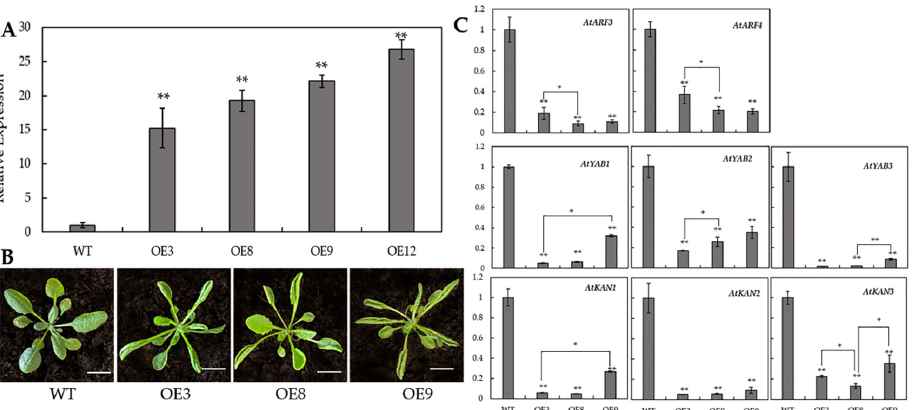
Figure 6. The analysis of transgenic BcAS2 lines. ( A ) Expression levels of BcAS2 in four positive overexpression (OE) lines and wild type (WT), respectively. ** means significant differences compared to WT ( p < 0.01). ( B ) Phenotype of the OE BcAS2 lines. Scale bar = 5 cM ( C ) The expression level analysis of eight polarity-related genes have been reported in Arabidopsis . The value of genes expression level in WT was set to ‘1’ as a control. The data represent the average of the three replicates, and the error bars represent the standard deviation between the replicates, *, p < 0.05, **, p < 0.01.